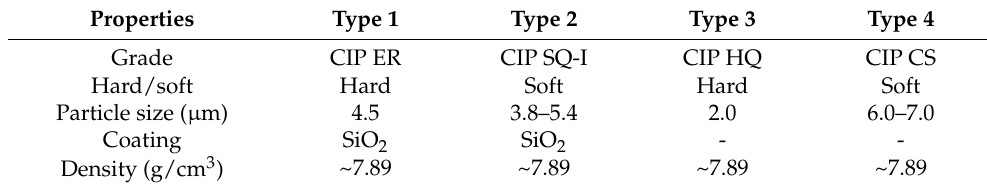
Table 2. Material properties of the carbonyl iron particles.